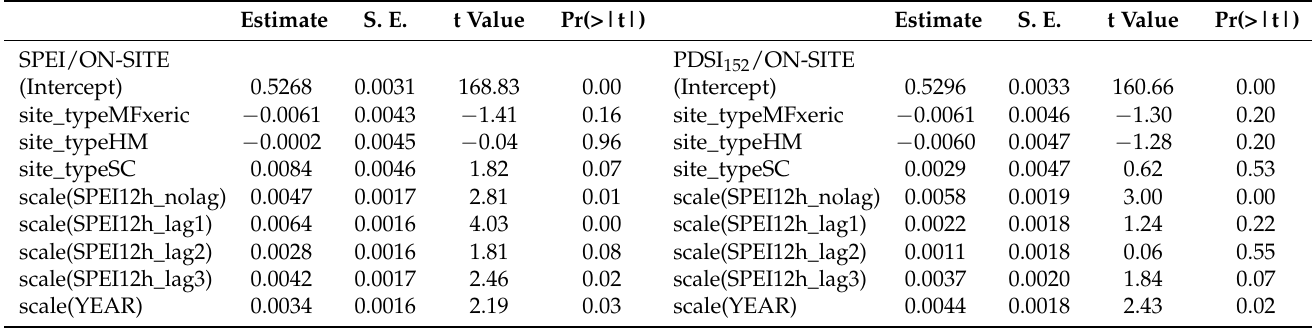
Table 4. Fitted models predicting NDVI from on-site or PRISM parameterized drought